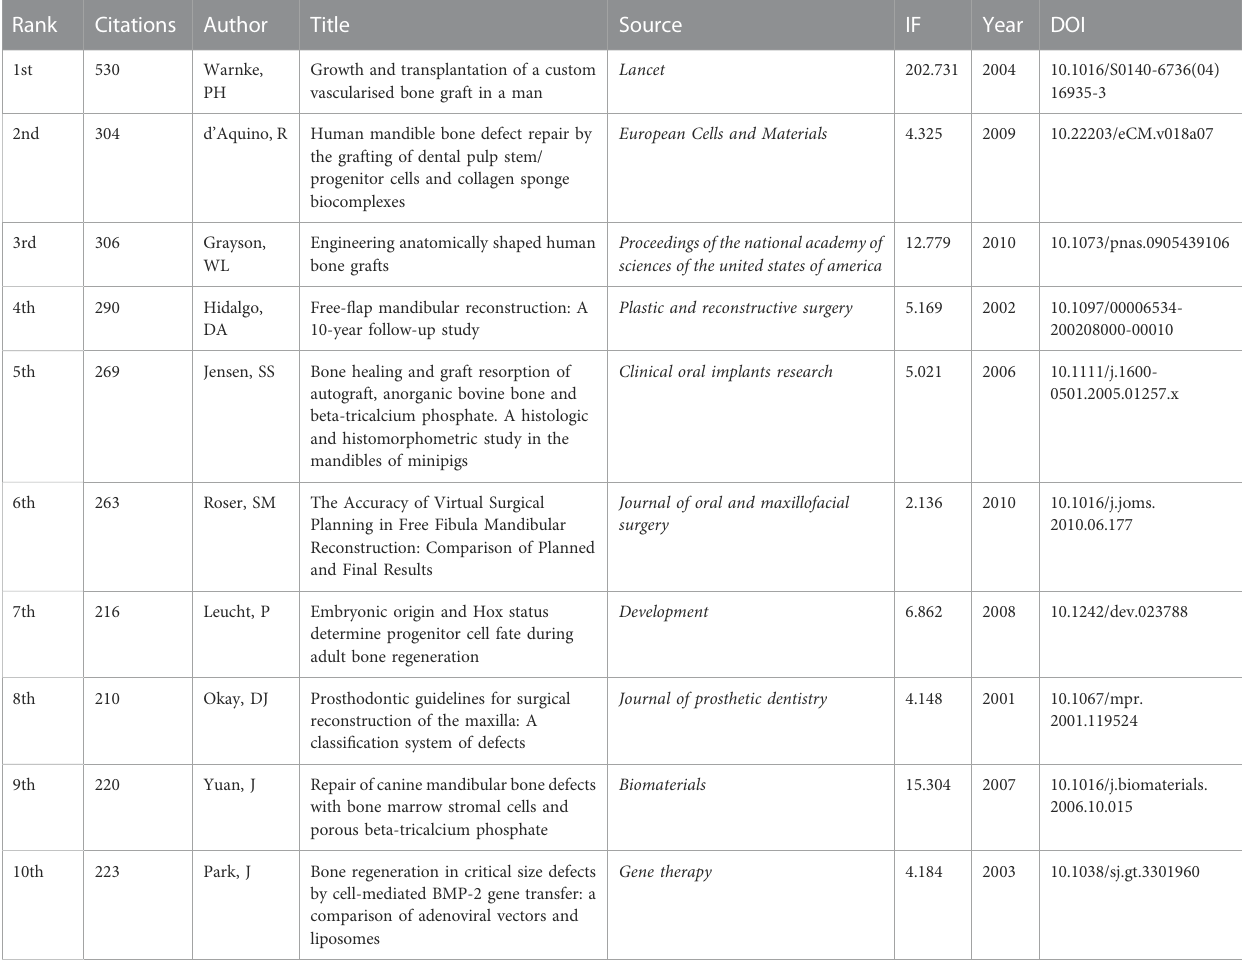
TABLE 3 Top ten highly cited literature of mandibular defect